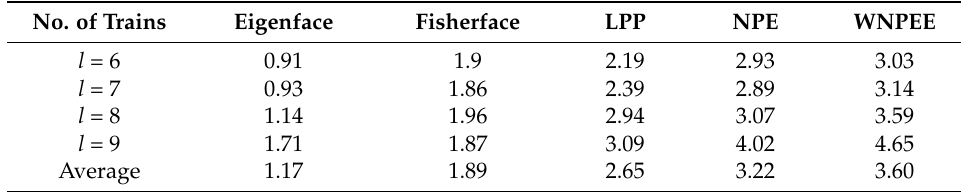
Table 5. Computation time on the YALE face database under different training for one run (time in seconds).